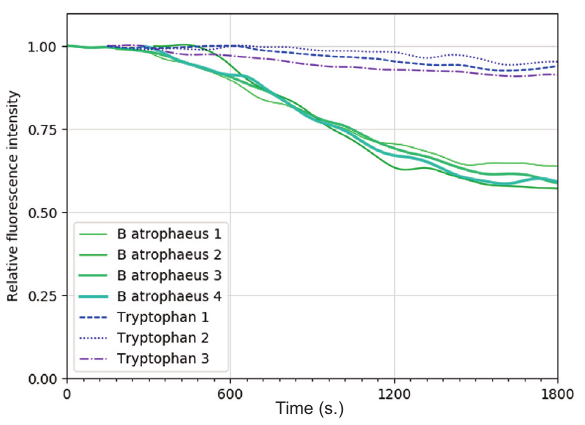
Fig. 7. Fluorescence signal fall­off in pure L­tryptophan versus B. atrophaeus spores under equal experimental conditions (partial pressure of HPV) and at comparable signal